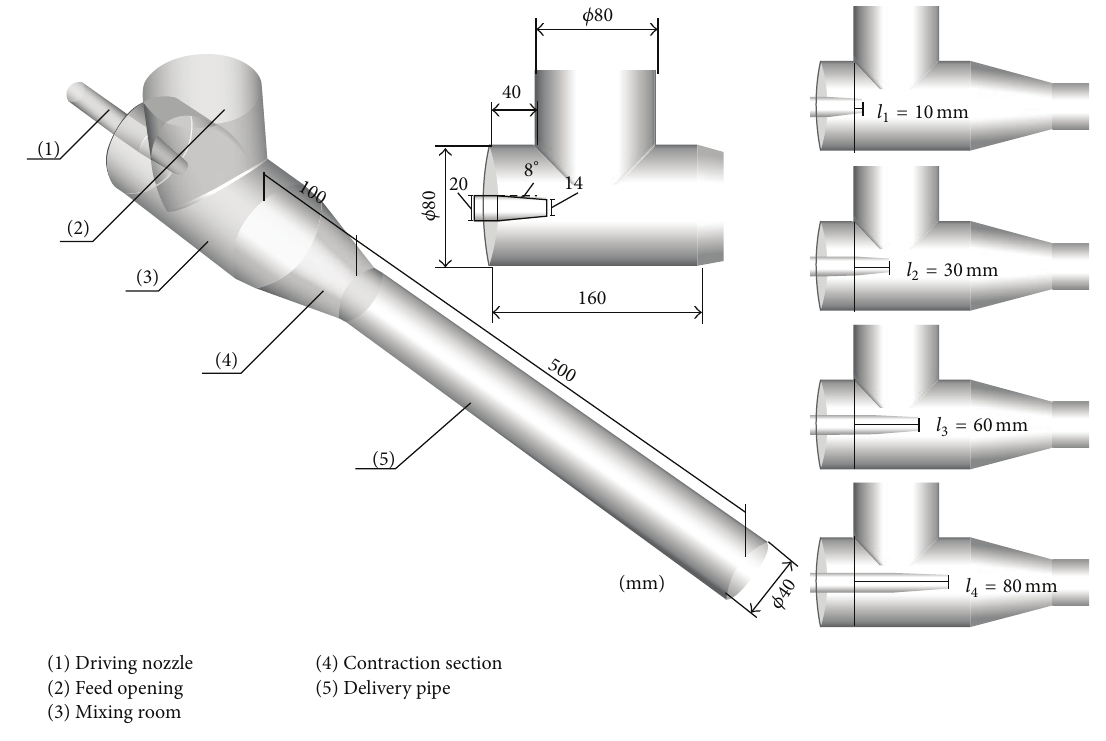
Figure 2: Simulation model of injector. Table 1: Initial parameters of simulation